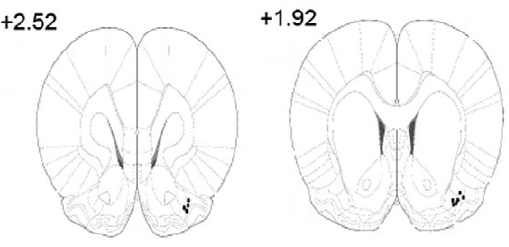
Figure 5. Recording electrode tip locations. Coronal sections of rat’s brain with distances from Bregma indicated. The black dots represent the recording site of each piriform cortex LFP. Atlas plates from Paxinos and Watson